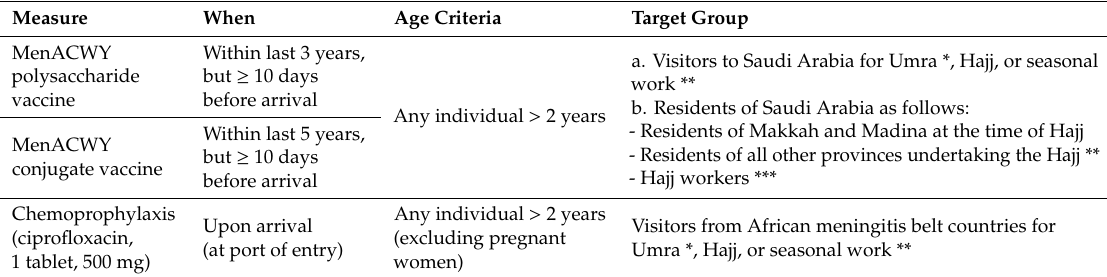
Table 1. Current preventive measures mandated by the Saudi Arabian government to control meningococcal disease during